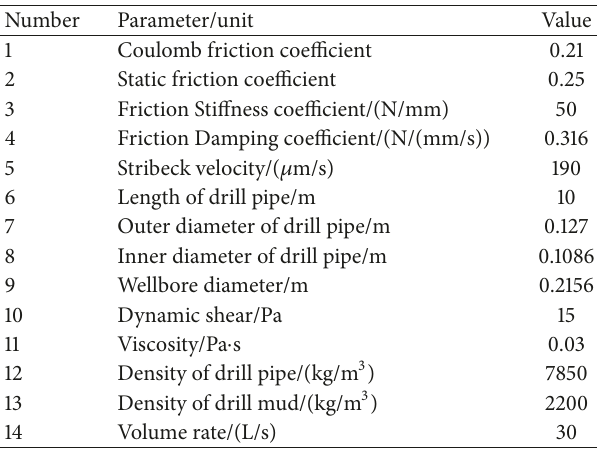
Table 1: Simulation parameters [12,